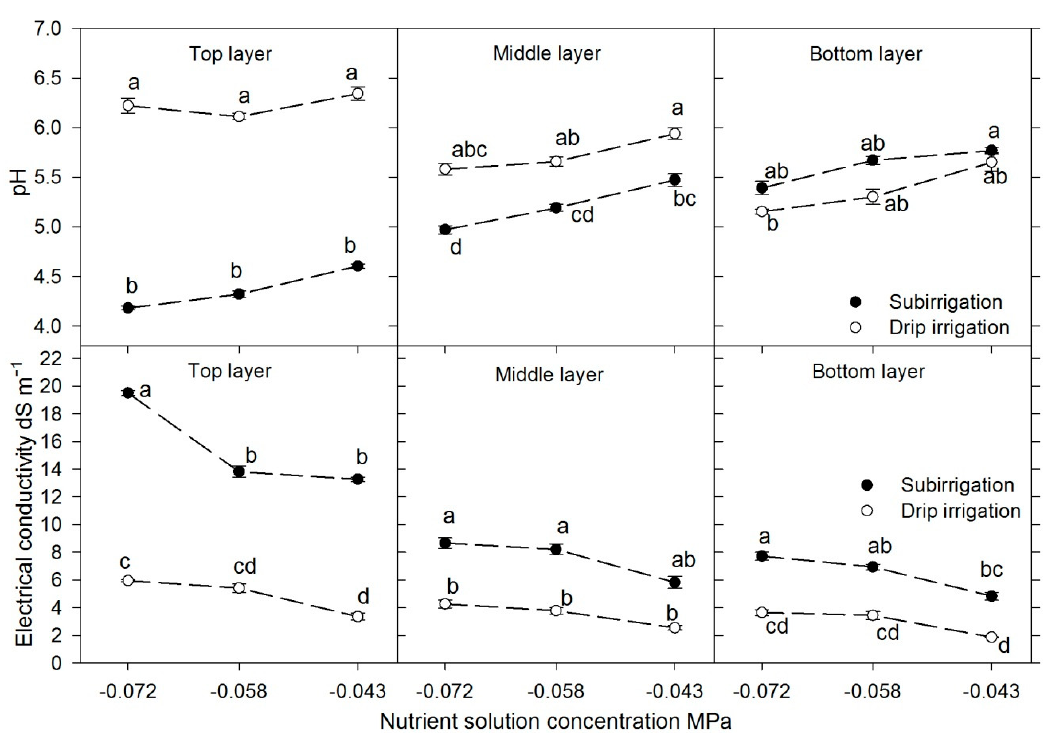
Figure 4. Substrate pH and electrical conductivity (EC) at the termination of the experiment with tomato ( Solanum lycopersicum L.) plants, as affected by, for pH, irrigation method (IM, p ≤ 0.001), nutrient solution concentration (NSC, p ≤ 0.001), substrate layers (SL, p ≤ 0.004) and the interactions between factors (IM × NSC, p = 0.354; IM × SL, p ≤ 0.001; NSC × SL, p = 0.666; IM × NSC × SL, p = 0.681), for EC, as affected by irrigation method (IM, p ≤ 0.001), nutrient solution concentration (NSC, p ≤ 0.001), substrate layers (SL, p ≤ 0.001) and the interactions between factors (IM × NSC, p ≤ 0.005; IM × SL, p ≤ 0.001; NSC × SL, p ≤ 0.006; IM × NSC × SL, p ≤ 0.019). Means with the same small case indicate non-significant differences according to Tukey´s multiple comparison test. Bars represent the standard error of the mean (n = 4).